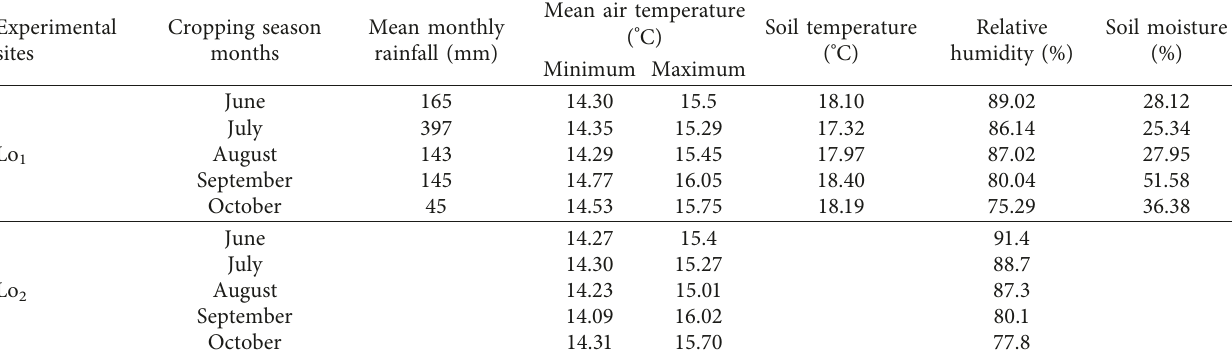
Table 1: Mean air temperature, monthly rainfall, soil temperature, relative humidity, and soil moisture in the Sinan and Debre Markos areas.